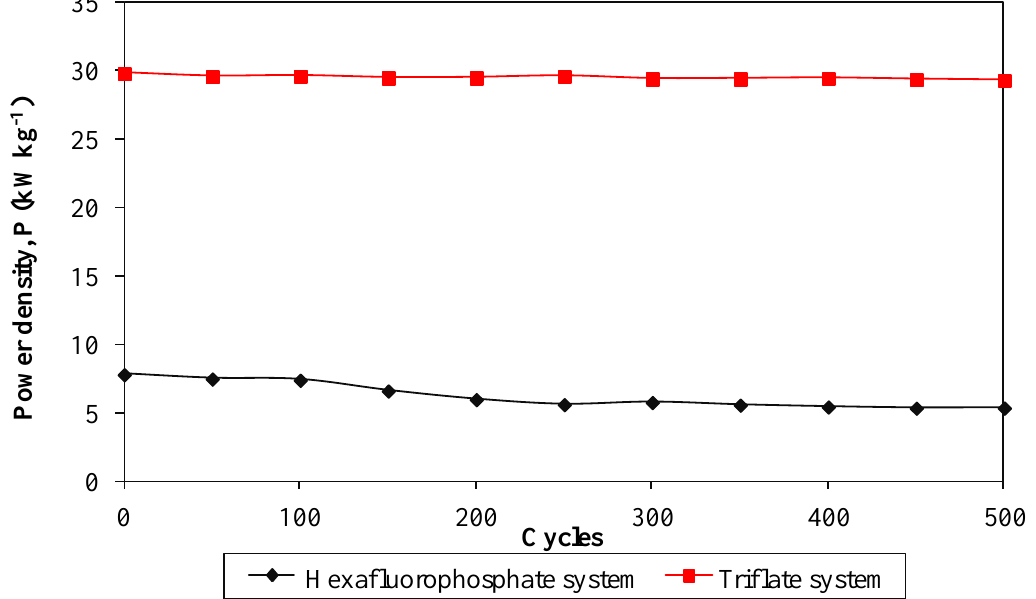
Figure 11. Power density of different ionic liquid-based biopolymer electrolyte systems over 500